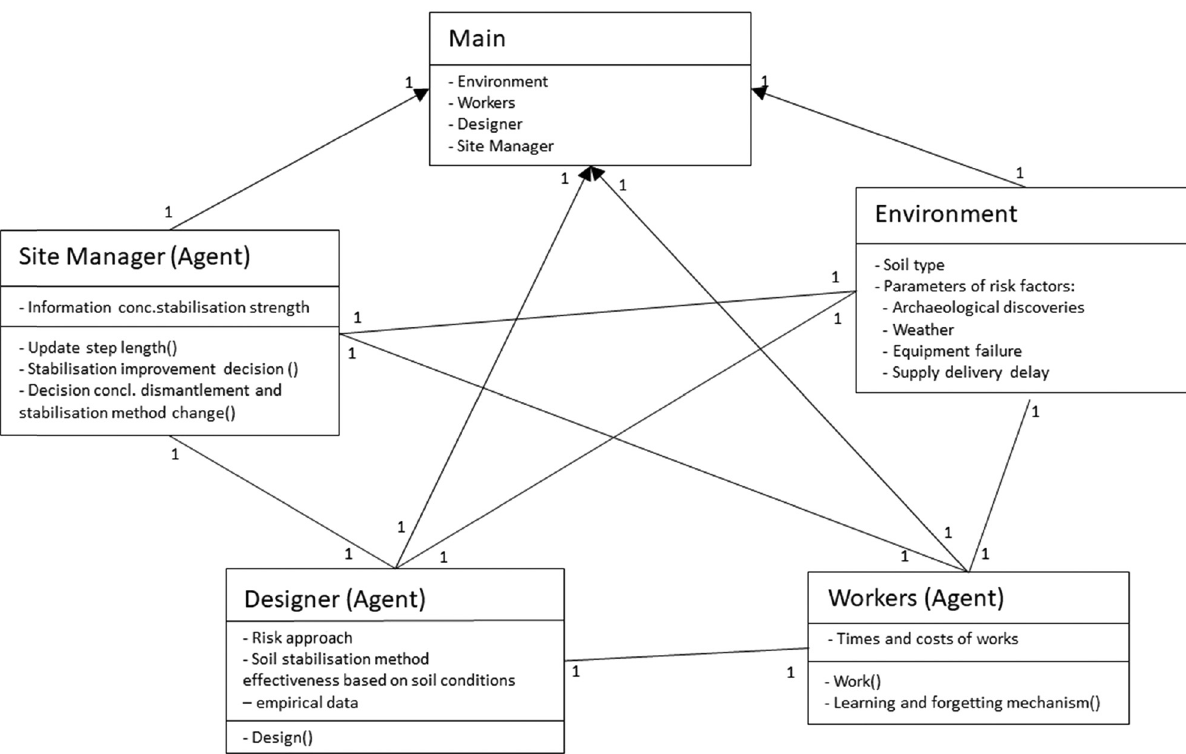
Figure 4: Class diagram of the agent - based model in